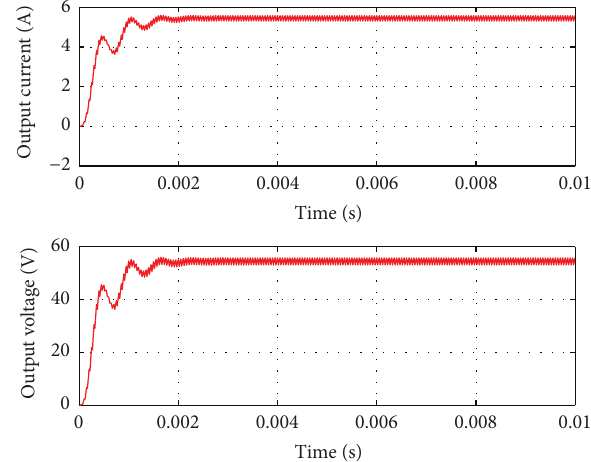
Figure 7: Output current and voltage of boost converter at constant 𝐷 .